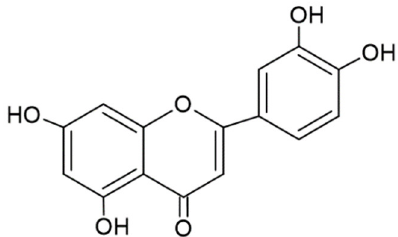
Figure 1. Chemical structure of luteolin.